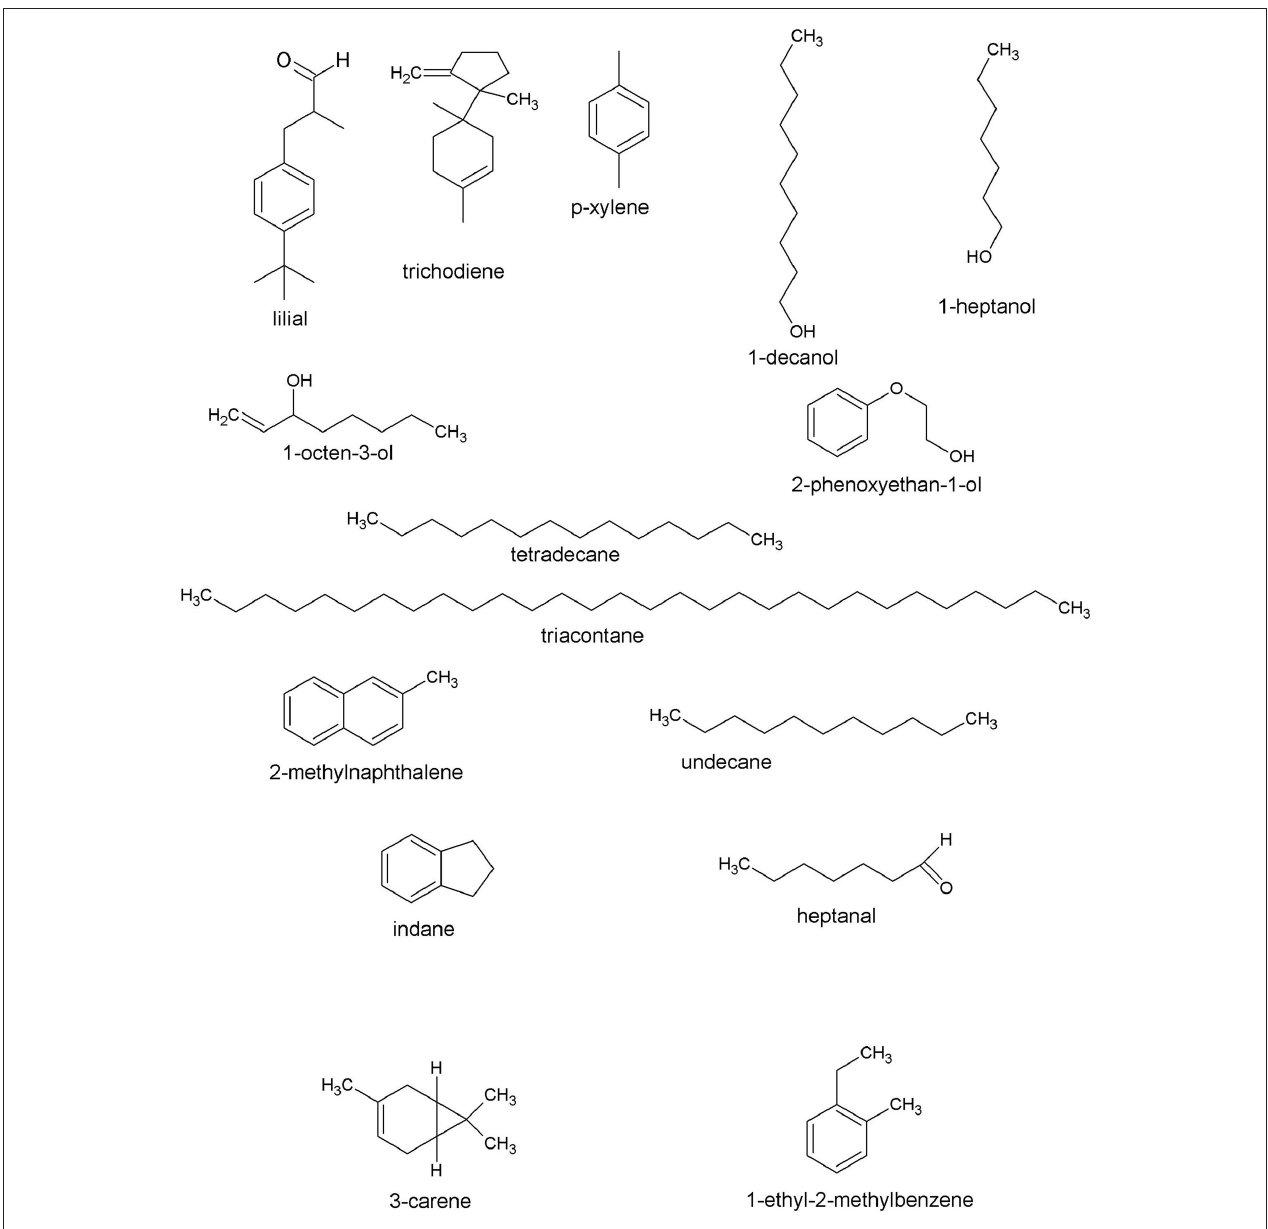
FIGURE 3 | Structures of volatile compounds included in model of